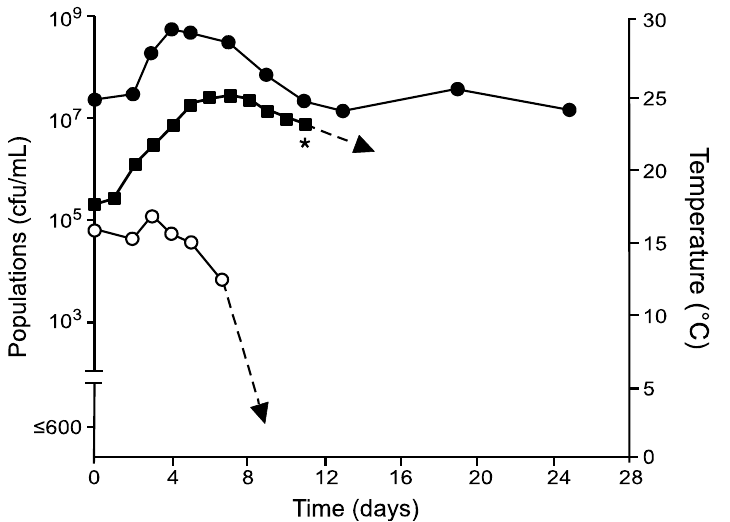
Figure 1. Culturable populations of S. cerevisiae ( ), total non- Saccharomyces yeasts ( ), and tem- peratures ( ) in grape musts inoculated on day 0 with S. cerevisiae following fermentation tempera- ture regime I. * Denotes time when the wine was pressed (approximately 0° Brix) prior to storage at 21 °C.